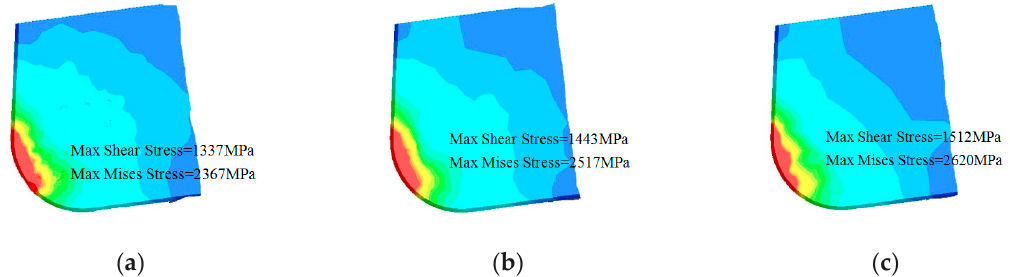
Figure 6. Comparison of max shear stress ans Mises stress : ( a ) d = 80 µm micro-hole tool; ( b ) d = 120 µm micro-hole tool; ( c ) non-textured tool.